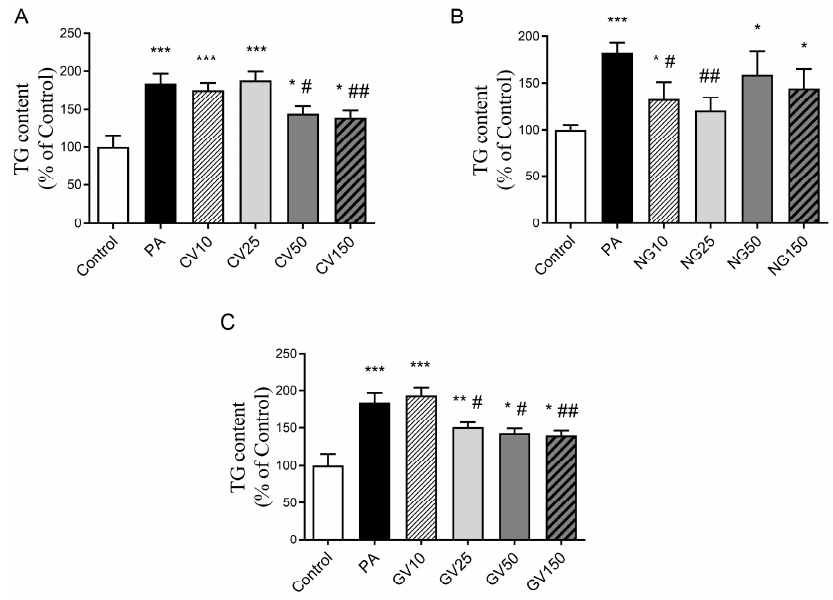
Figure 3. Triglyceride (TG) content in AML12 hepatocytes exposed or not to 0.3 mM of palmitic acid (PA) with or without Chlorella vulgaris (CV) ( A ) , Nannochloropsis gaditana (NG) ( B ) , and Gracilaria vermiculophylla (GV) ( C ) at 10, 25, 50 or 150 µg/mL for 18 h. Data are means ± SEM (standard error of the mean). * p < 0.05, ** p < 0.01 and *** p < 0.001 vs. control cells, # p < 0.05 and ## p < 0.01 vs. PA cells.